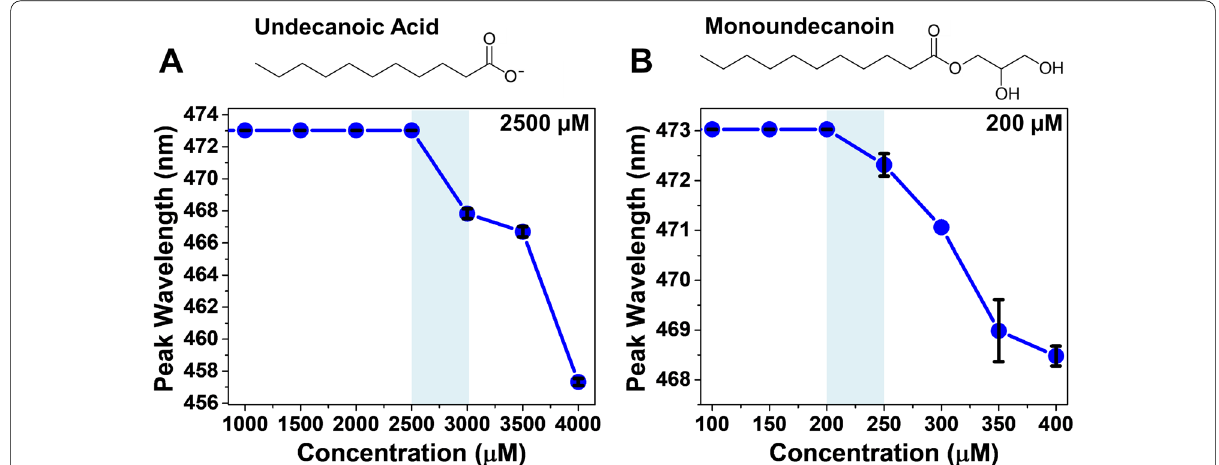
Fig. 2 Determination of CMC values for undecanoic acid and monoundecanoin. Fluorescence emission peak wavelength as a function of compound concentrations in PBS solution are presented for ( A ) undecanoic acid and ( B ) monoundecanoin. Each data point reflects the mean of six technical replicates as well as the standard deviation (expressed as error bars). The shaded region highlights the CMC value for the compounds, which is the highest concentration at which no wavelength shift occurs. The molecular structure of each compound is shown